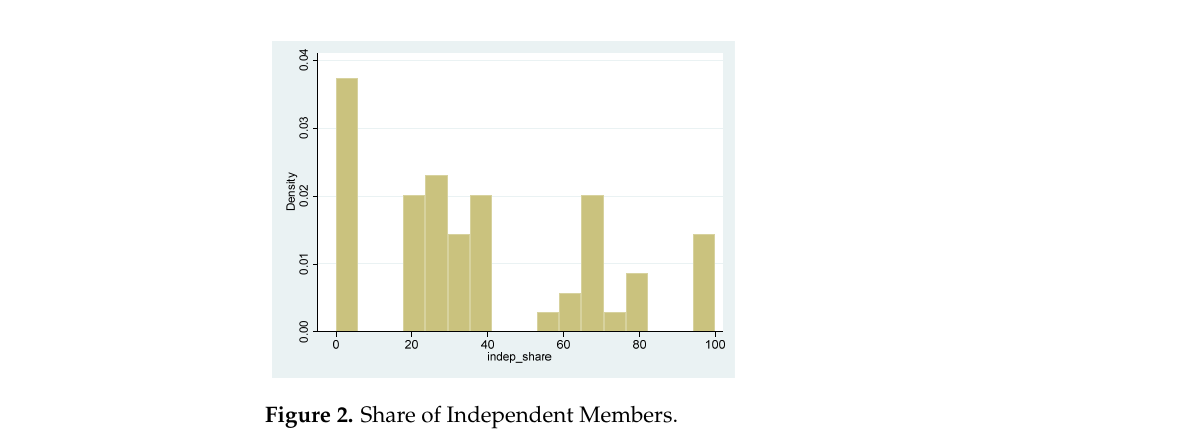
Figure 2. Share of Independent Members. Table 3. Cross Correlations.